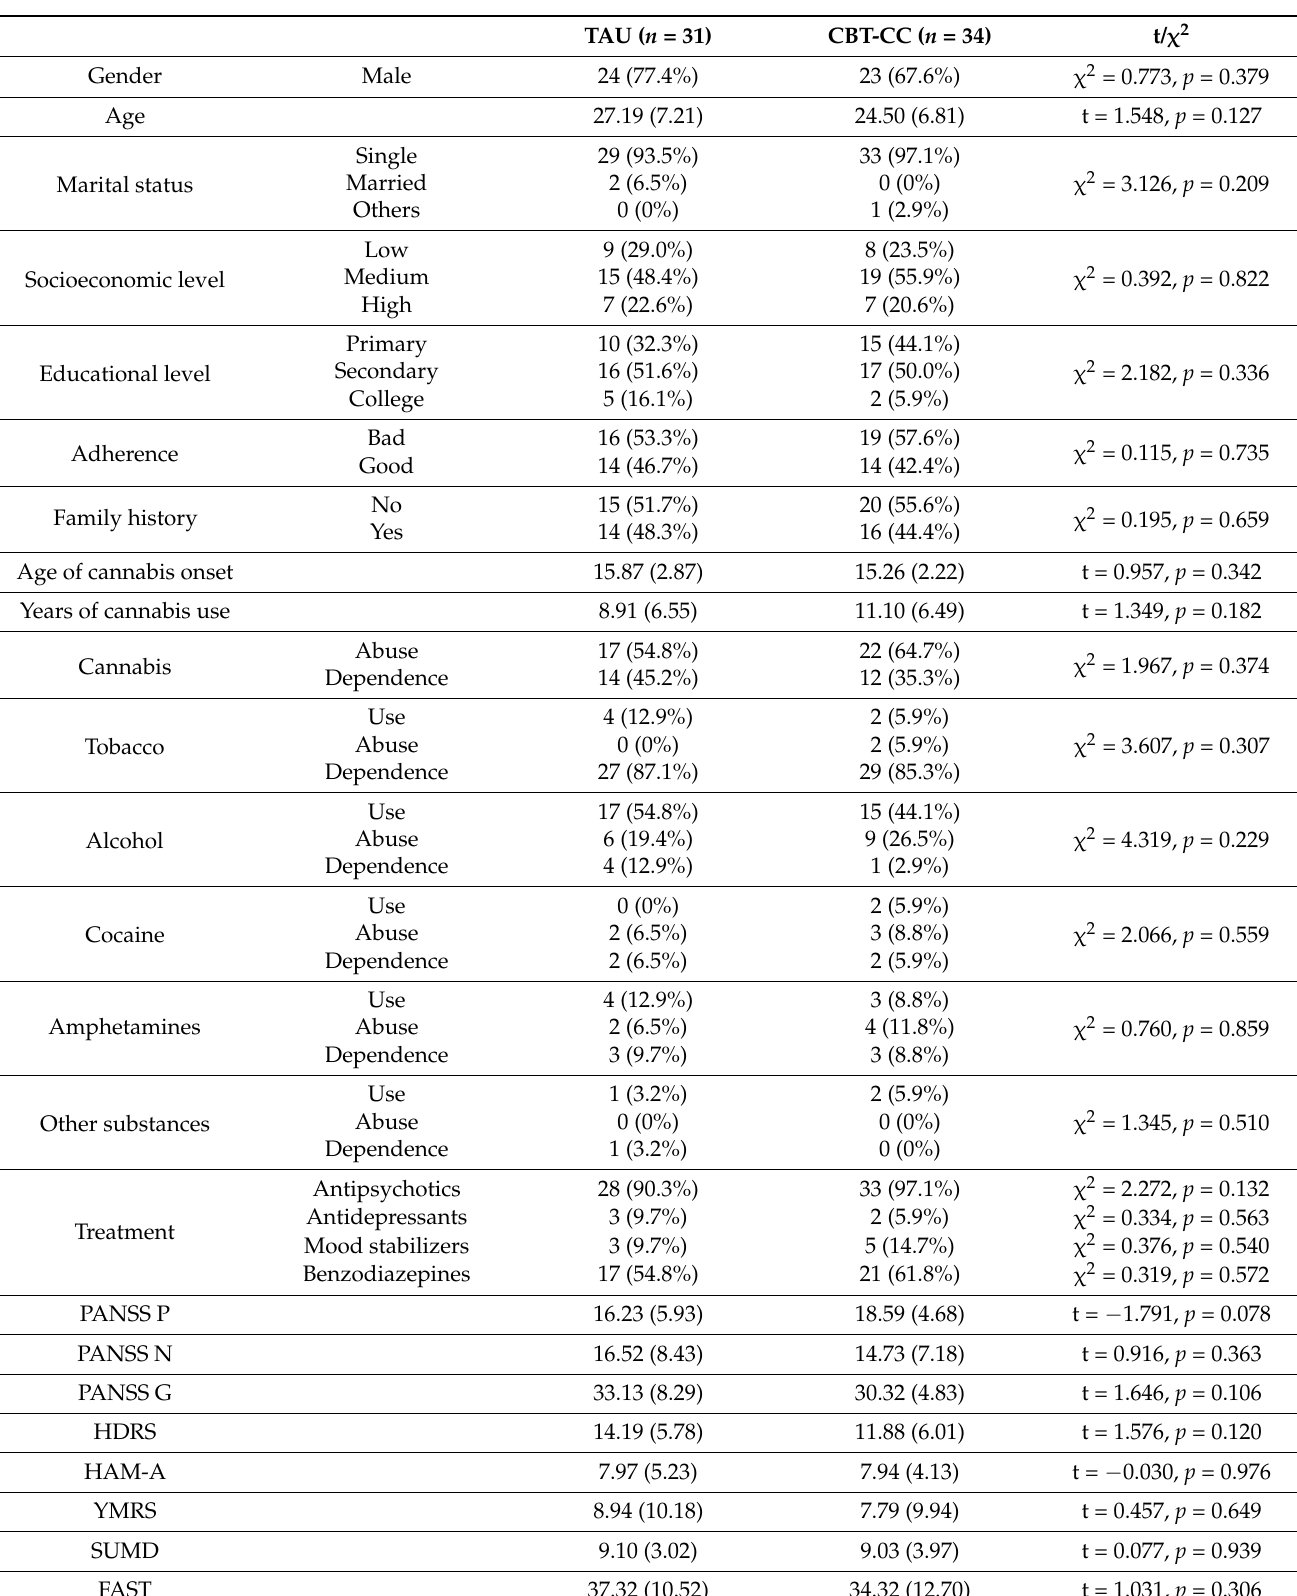
Table 2. Baseline sociodemographic and clinical characteristics of the